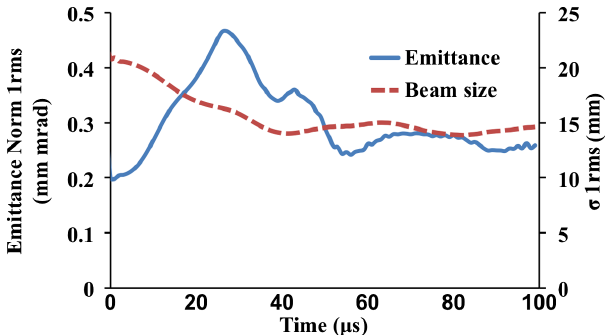
FIG. 4. Normalized emittance and beam size evolution in time after a 0.7 m drift; the input emittance is 0.2 mm